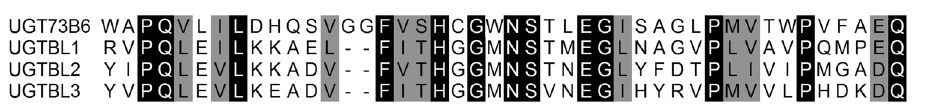
(Fig. 3). The PSPG motif similarity of these three mined genes cloned from ZSP01 are identical with the result of AGN36351, AGN35336 and AGN34962, proving the high conservation of PSPG motif in family 1 GTs. Functional validation of the mined microbial GTs.